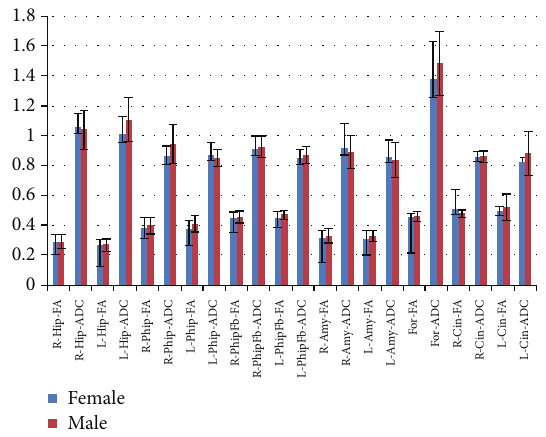
Figure 3: The ADC values of hippocampus, parahippocampus, and fornix were found to be higher in